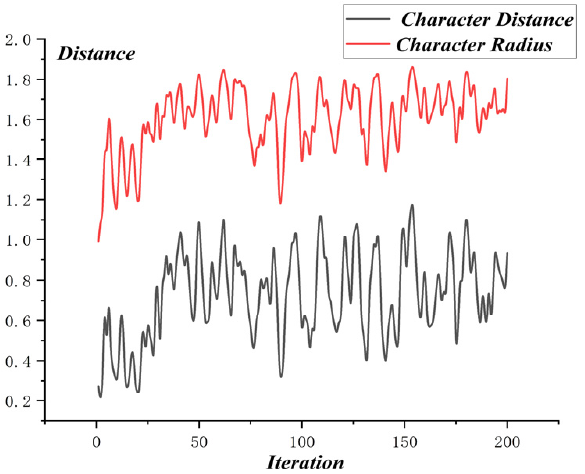
Figure 12. Optimization process of NSGA-2.